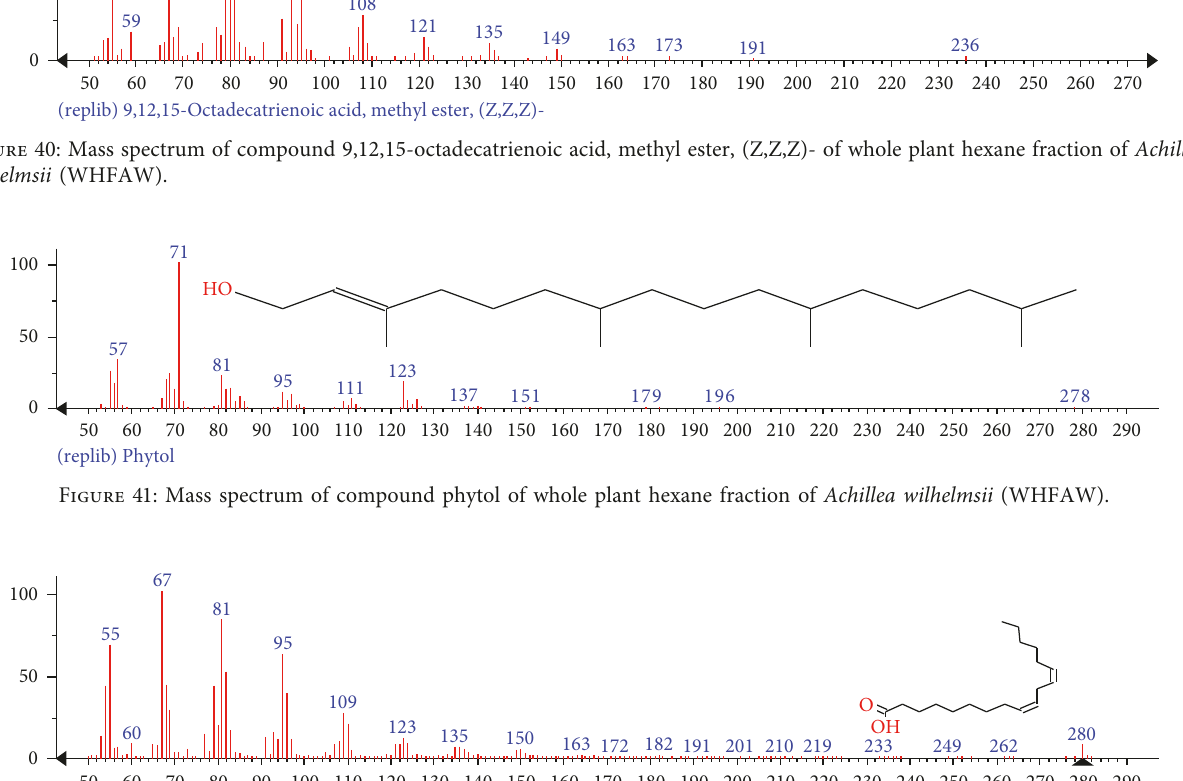
(Z,Z)-50 60 70 80 90 100 110 120 130 140 150 160 170 180 190 200 210 220 230 240 250 260 270 280 (replib) 9,12-Octadecadienoic acid Figure 42: Mass spectrum of compound 9,12-octadecadienoic acid (Z,Z)- of whole plant hexane fraction of Achillea wilhelmsii (WHFAW).